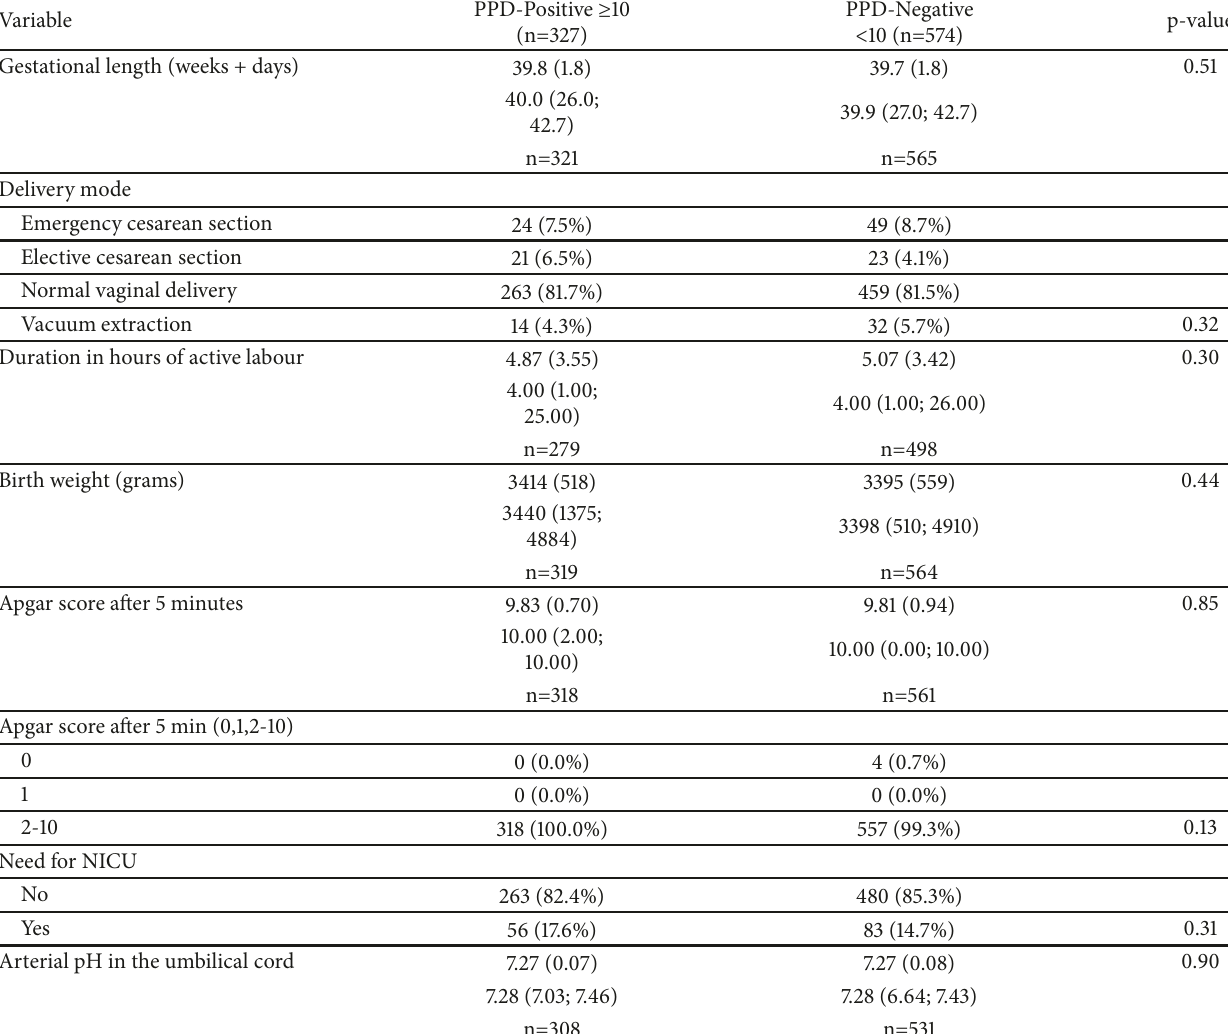
Table 2: Comparison of labour and fetal outcomes between pregnant women with PPD ≥ 10 and normal PPD <